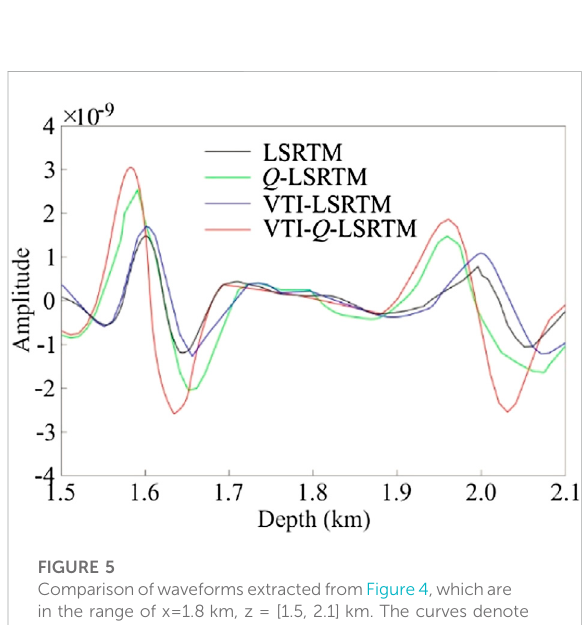
LSRTM images obtained by different methods of the gas block model. (A) LSRTM image, (B) viscoacoustic LSRTM image, (C) VTI LSRTM image, and (D) viscoacoustic VTI LSRTM image. And the color scales of all the images are the same.